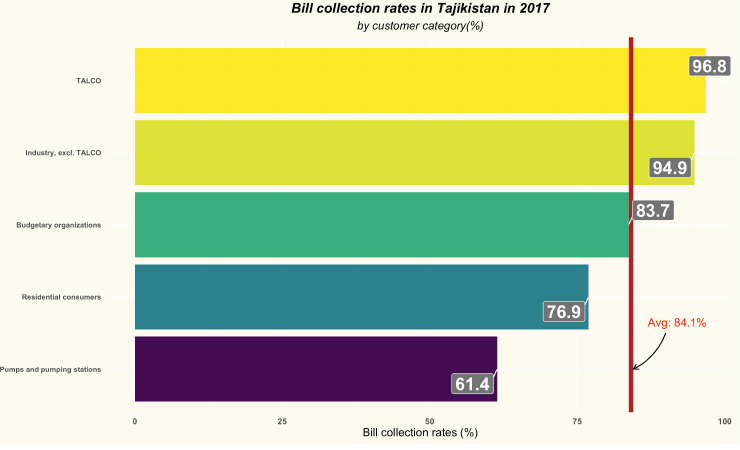
Figure 9. Bill collection rates in Tajikistan in 2017. Data source: World